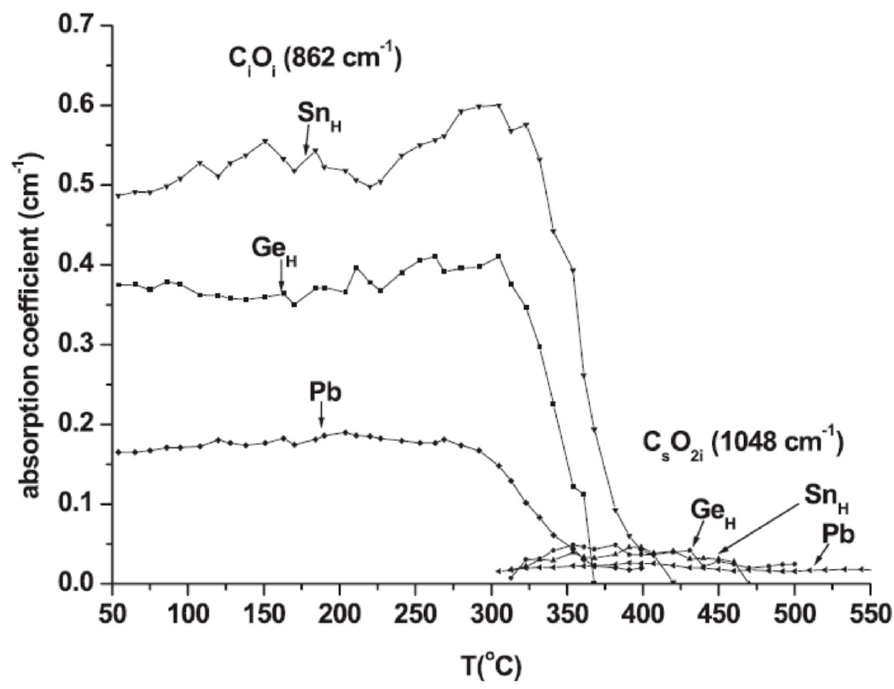
Figure 18. The annealing behavior of C i O i and C s O 2i defects for various isovalent dopants. Repro- duced with permission from [155]. American Institute of Physics, 2013.